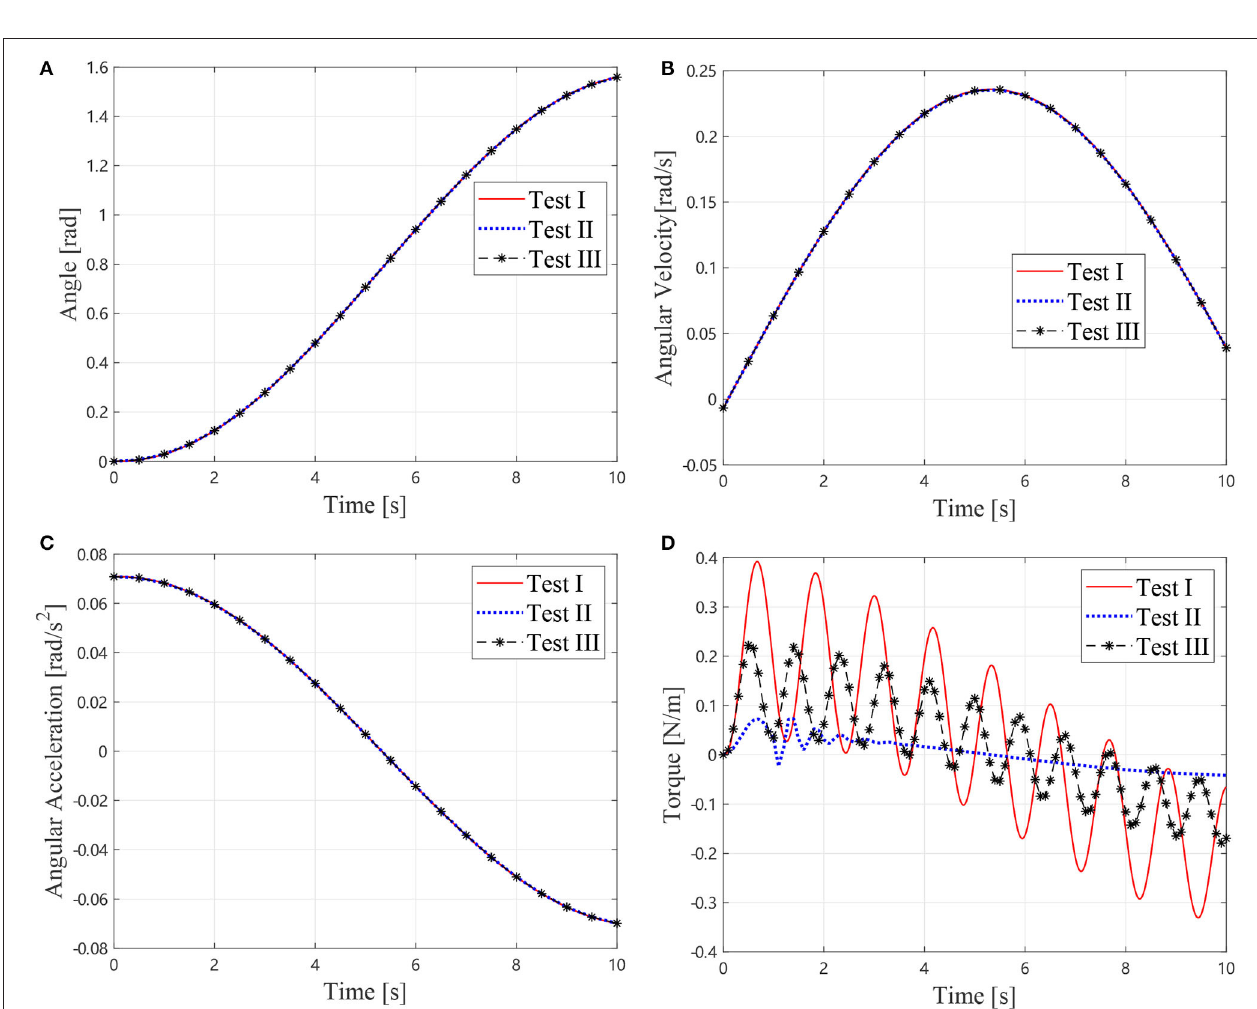
FIGURE 5 | Motions and torque of the simlational Test I, II, and III, (A) Joint angles, (B) Joint angular velocties, (C) Joint angular accelerations, and (D) Joint torque.